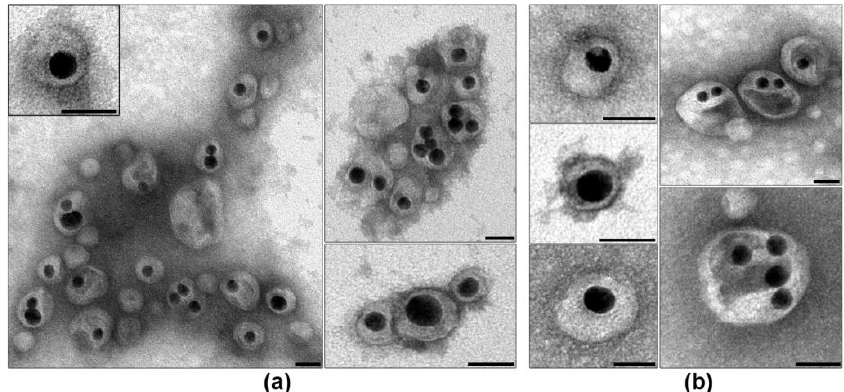
Figure 9. Suspension of nanospecies obtained after enveloping of siRNA-Au (cores) with LM2. Box ( a ) Note asymmetrical location of a core inside the construction, a particle at high magnification is shown in the insert. Representing images of siRNA-Au-LM2-P’ particles are shown in box ( b ). Contrasting with uranyl acetate. Length of scale bars corresponds to 25 nm.